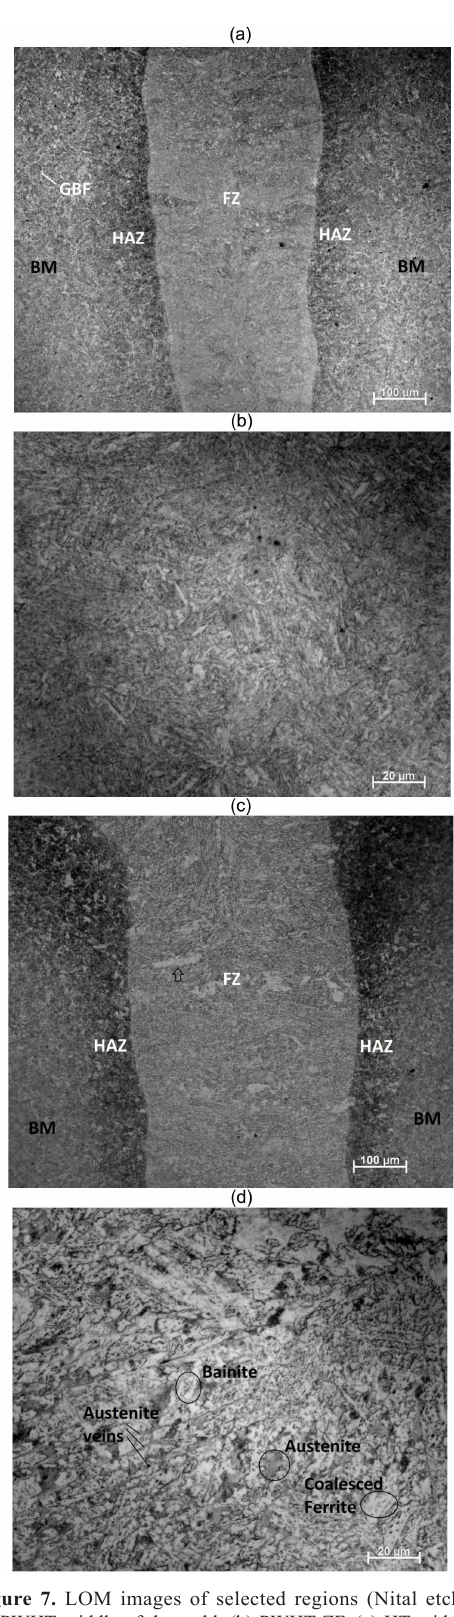
Figure 7. LOM images of selected regions (Nital etched): (a) PWHT middle of the weld. (b) PWHT ZF. (c) HT middle of the weld. (d) HT